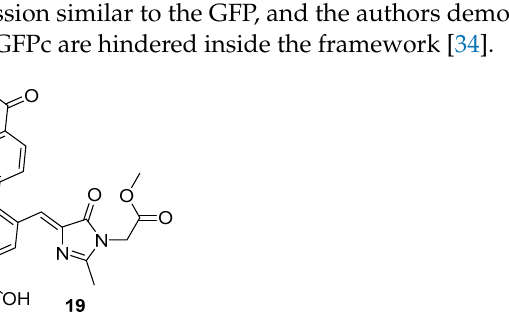
Figure 19. GFPc analogue used as linker in the preparation of a green-fluorescent metal–organic framework [34].